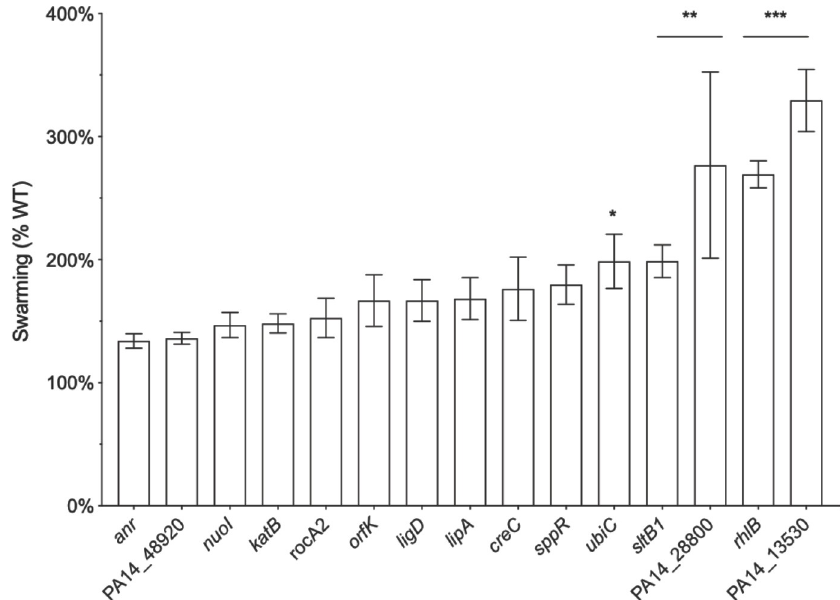
Fig 3. Selected PA14 transposon mutants that swarmed in the presence of 0.75 μ g/ml peptide 1018. Briefly, BM2 swarm plates (with 0.75 μ g/ml 1018) were inoculated with 1 μ l of planktonic cells suspended at an OD 600 of 0.4–0.6 in BM2 and then incubated for 20 h at 37˚C. At least three biological replicates for each transposon mutant were examined. Mean and standard error of the mean are shown. � P < 0.05, �� P < 0.01, ��� P < 0.001 according to Kruskal–Wallis test followed by Dunnett’s post hoc